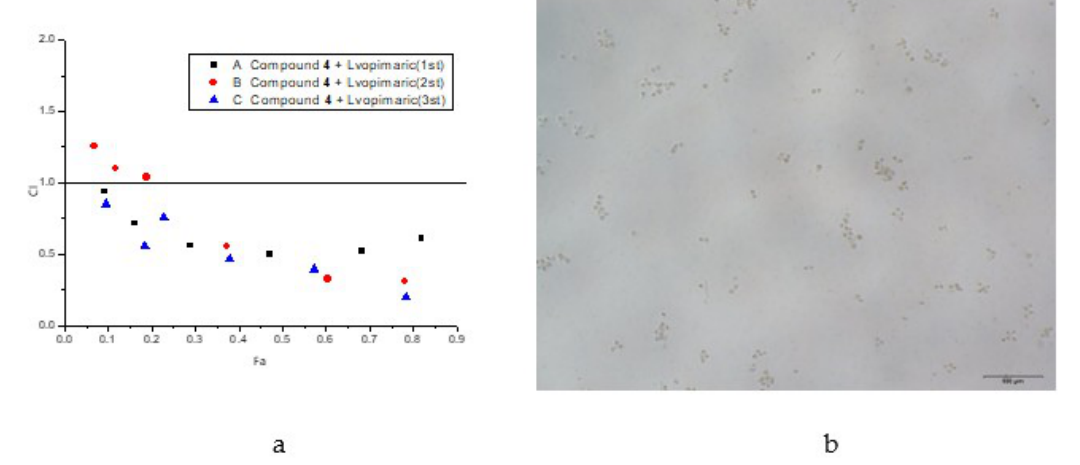
Figure 9. Confidence interval CI–Fa relationship ( a ) (CI = 0.211) and HepG2 apoptosis ( b ). Statistical analysis: A p < 0.05 was considered significant.